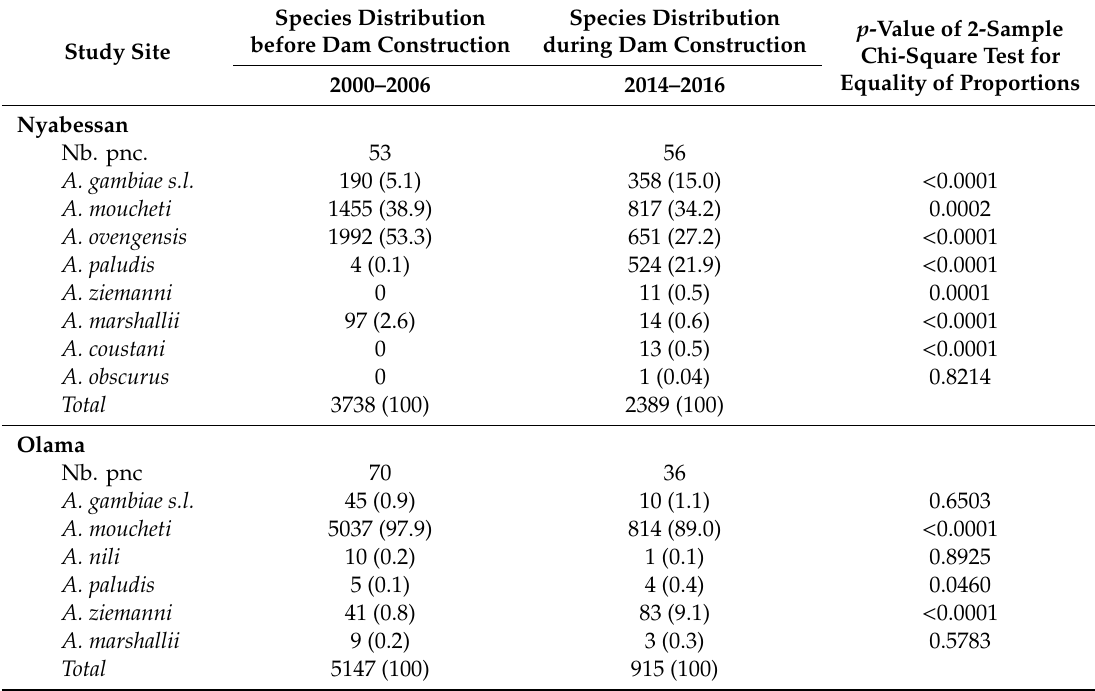
Species Distribution during Dam Construction